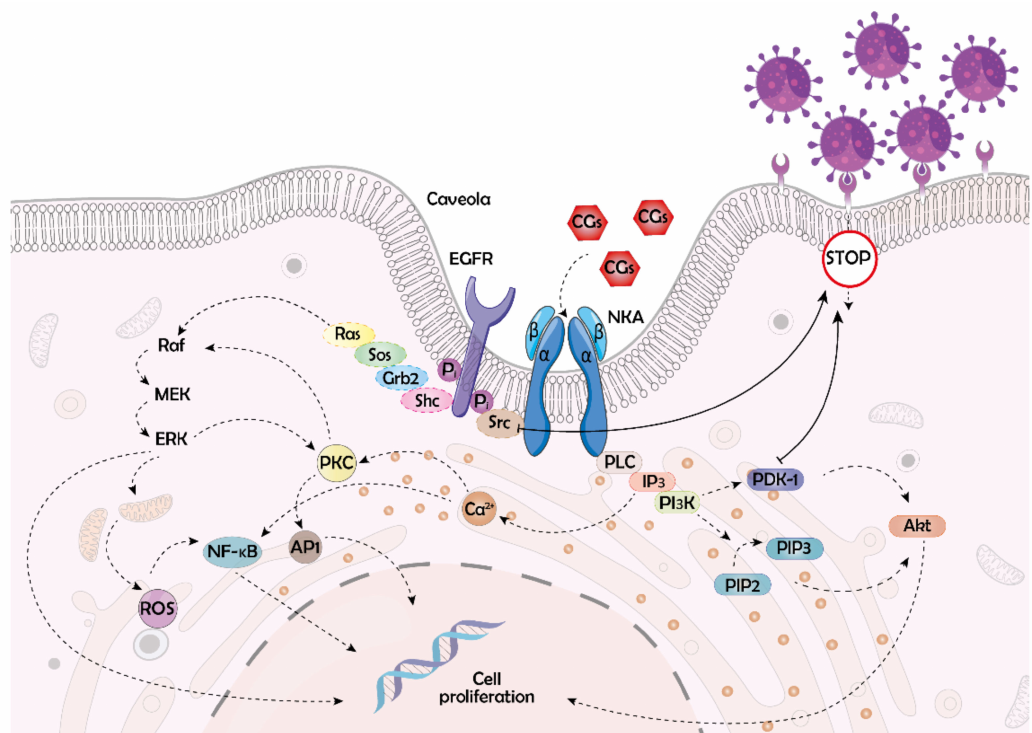
Figure 3. Molecular pathways triggered by binding of cardiac glycosides (CGs) to the α -subunit of Na + /K + -ATPase (NKA), which are involved in blocking the viral entry into host cells. By CG binding to NKA, conformational changes of its α -subunit trigger non-receptor tyrosine kinase (Src) to phosphorylate the epidermal growth factor receptor (EGFR). This leads to activation of Src homology 2 domain-containing transforming protein (Shc)/growth factor receptor-bound protein 2 (Grb2)/son of sevenless protein (Sos)/rat sarcoma protein (Ras) pathway. Ras further activates the serine/threonine kinase (Raf)/mitogen-activated protein kinase kinase (MEK)/extracellular signal-regulated kinase (ERK) pathway, which triggers reactive oxygen species (ROS) production activating nuclear factor kappa-light-chain-enhancer of activated B cells (NF- κ B) and thereby affects the expression of genes in the nucleus and cell proliferation. The cell proliferation is affected also by protein kinase C (PKC), which activates transcription factors, such as AP1. PKC itself is activated either via the Ras/Raf/MEK/ERK pathway or by Ca 2+ ions. The levels of Ca 2+ can be elevated by another NKA-based pathway, the phospholipase C (PLC)/inositol triphosphate (IP 3 )/phosphatidylinositol-3 kinase (PI3K). The latter enzyme is responsible for the transformation of phosphatidylinositol-2-phosphate (PIP2) into phosphatidylinositol-3-phosphate. The PLC/IP3/PI3K pathway is responsible also for blocking the viral entry into cells, however, the exact mechanism of this process has been unclear, so far. The only involvement of 3-phosphoinositide-dependent protein kinase 1 (PDK1) has been proven. This enzyme physiologically activates protein kinase B (Akt), which then enters the cell nucleus and affects gene transcription. Besides, the viral entry into the host cells is blocked directly by Src, also with an unknown mechanism. Surprisingly, Yang et al. [68] recently reported also an NKA-independent mechanism of the antiviral action of CGs against coronaviruses. It is based on Janus kinase 1